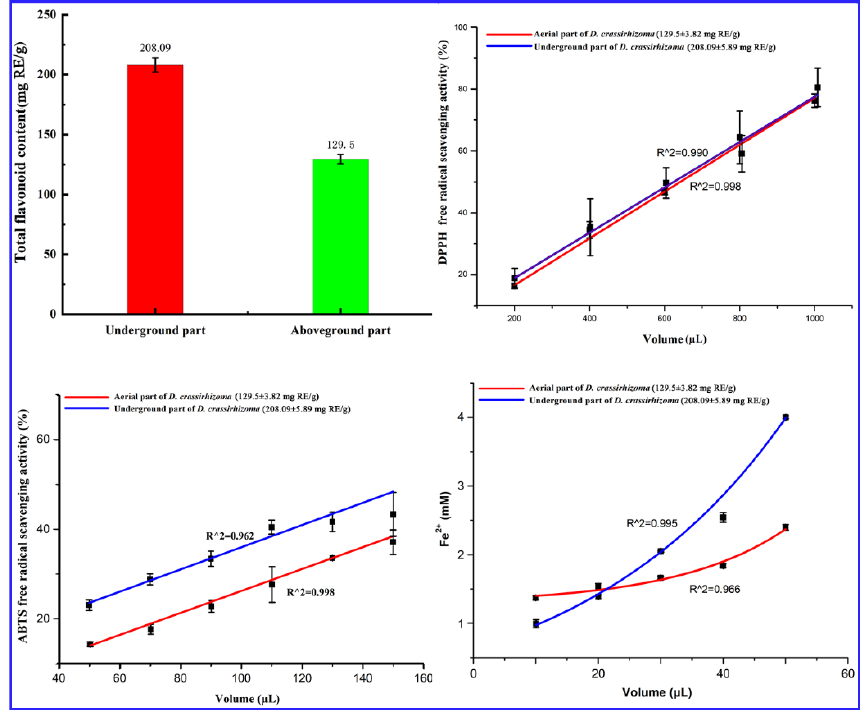
Figure 3. Comparison of total flavonoid content and antioxidant activities of above-ground and underground parts of Dryopteris crassirhizoma .